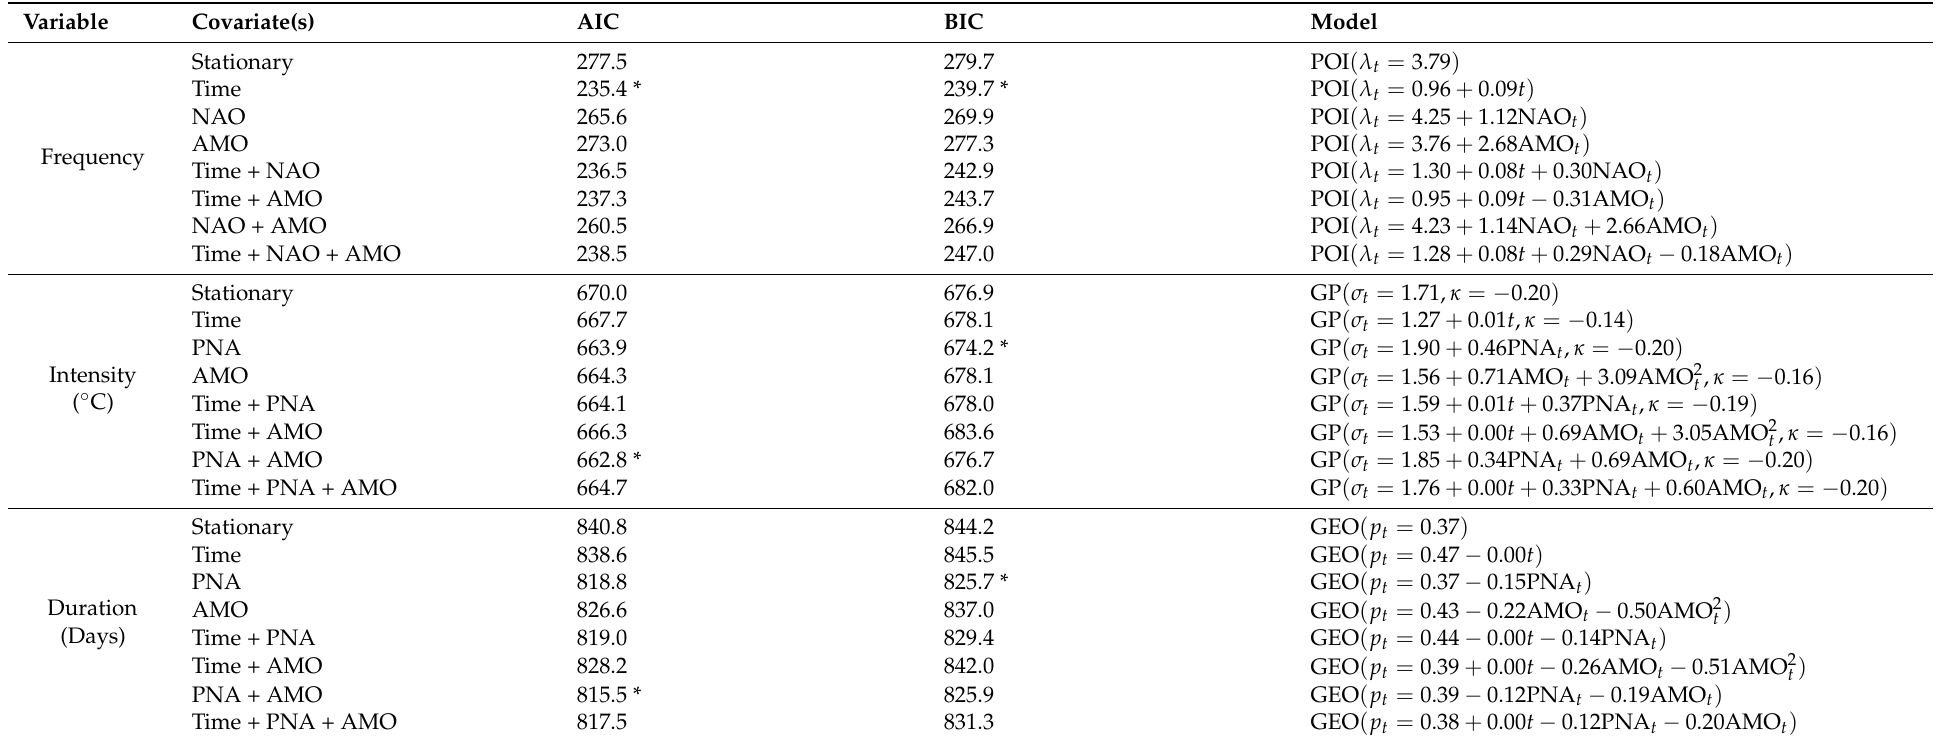
Table 3. The Orange station corresponds to stationary/non-stationary models for each heat spell variable. AIC and BIC statistics for the optimal model of each configuration of covariates. For non-stationary models, different combinations of covariates were considered. In each case, the optimal model based on the AIC statistic is